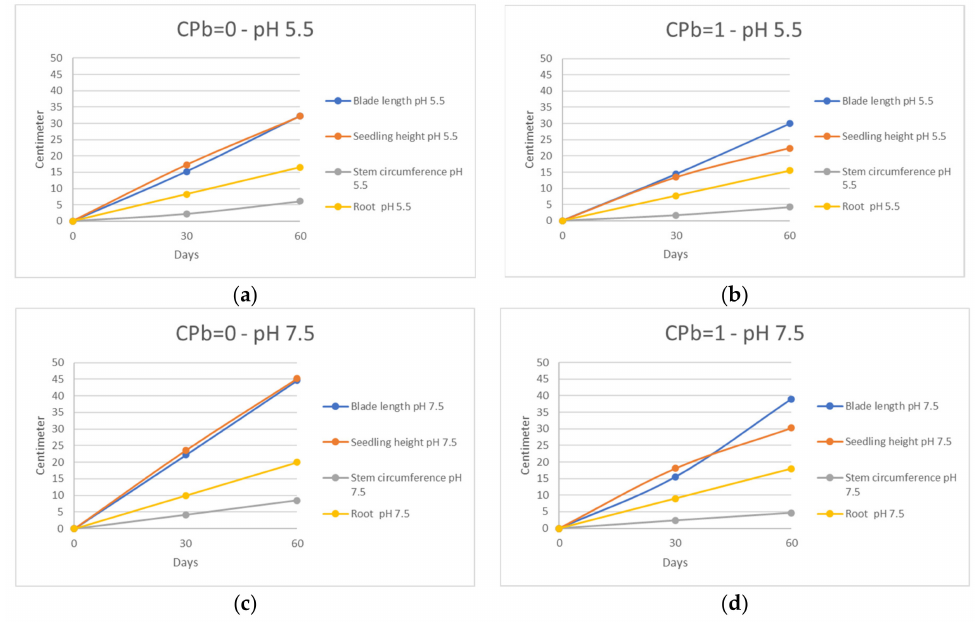
Figure 9. Comparative graph of the parameters of the double bottom irrigation units. ( a ) No lead contamination (CPb = 0) with a pH of 5.5 ( b ) at the maximum established lead concentration (CPb = 1) with a pH of 5.5. ( c ) No lead contamination (CPb = 0) with a pH of 7.5, and ( d ) at the maximum established lead concentration (CPb = 1) with a pH of 7.5. Note: The 30-day root length value is calculated as half the 60-day root value, given the impossibility of measuring it until the end of the experiment. Data collected by the